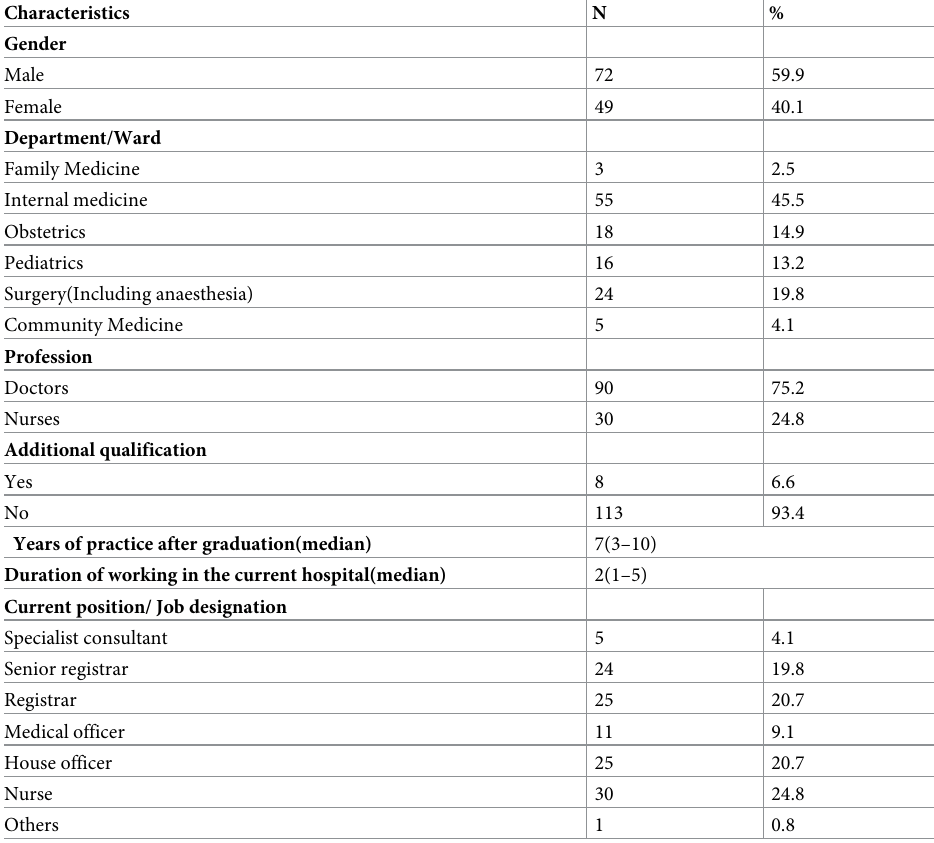
Table 2. Professional profile of the respondents.